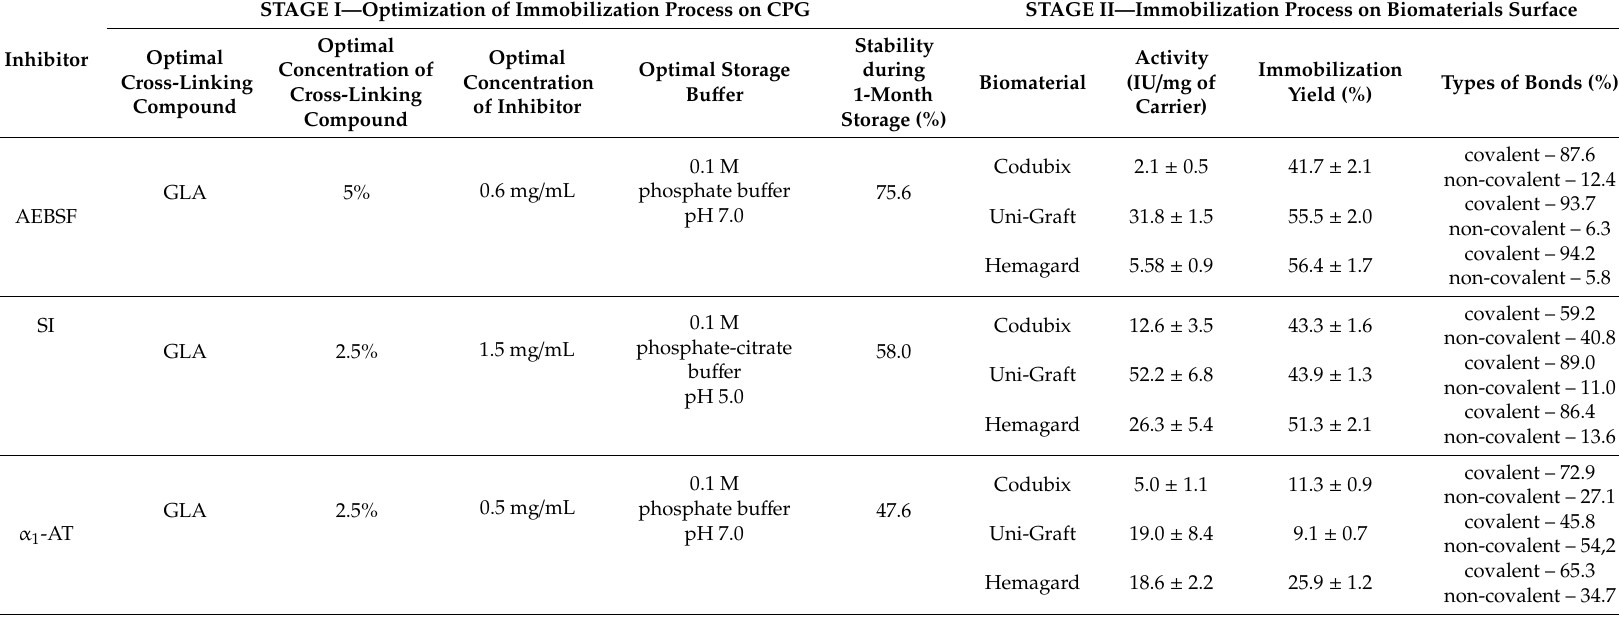
Table 2. Summary of optimal parameters of immobilization for three serine protease inhibitors and characterization of their activity, immobilization yield, and specificity of binding on the surface of studied polymer